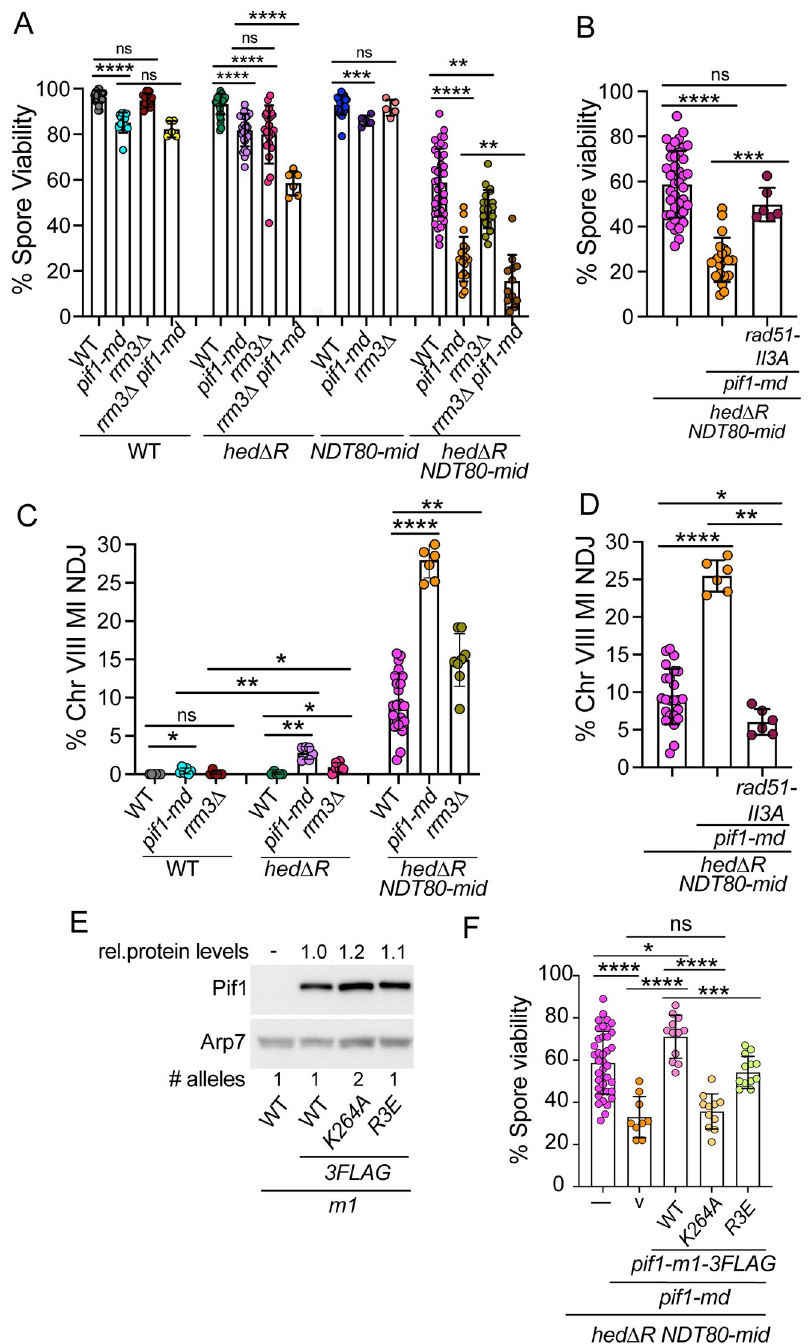
Fig 8. PIF1 and RRM3 promote homolog disjunction when Rad51 is constitutively activated in the absence of the meiotic recombination checkpoint. (A) Spore viability. The data from WT, hed Δ R , NDT80-mid and hed Δ R NDT80-mid were taken from Fig 3E. Additional strains were pif1-md (NH2657 or NH2685 RCEN), rrm3 Δ (NH2485:: pRS304 2 or NH2623 RCEN), pif1-md rrm3 Δ (NH2671::pRS304 2 ), hed Δ R pif1-md (NH2691 or NH2702 RCEN), hed Δ R rrm3 Δ (NH2540 or NH2629 RCEN), hed Δ R pif1-md rrm3 Δ (NH2704), NDT80-mid pif1-md (NH2725), NDT80-mid rrm3 Δ (NH2549), hed Δ R NDT80-mid pif1-md (NH2661 or NH2687 RCEN), hed Δ R NDT80-mid rrm3 Δ (NH2596), and hed Δ R NDT80-mid pif1-md rrm3 Δ (NH2670). Sporulated cells from both liquid and solid sporulation media were dissected to determine the percent of viable spores. At least 20 tetrads were dissected for each replicate. (B) Suppression of hed Δ R NDT80-mid pif1-md spore inviability by rad51-II3A (NH2741 RCEN). (C) Frequency